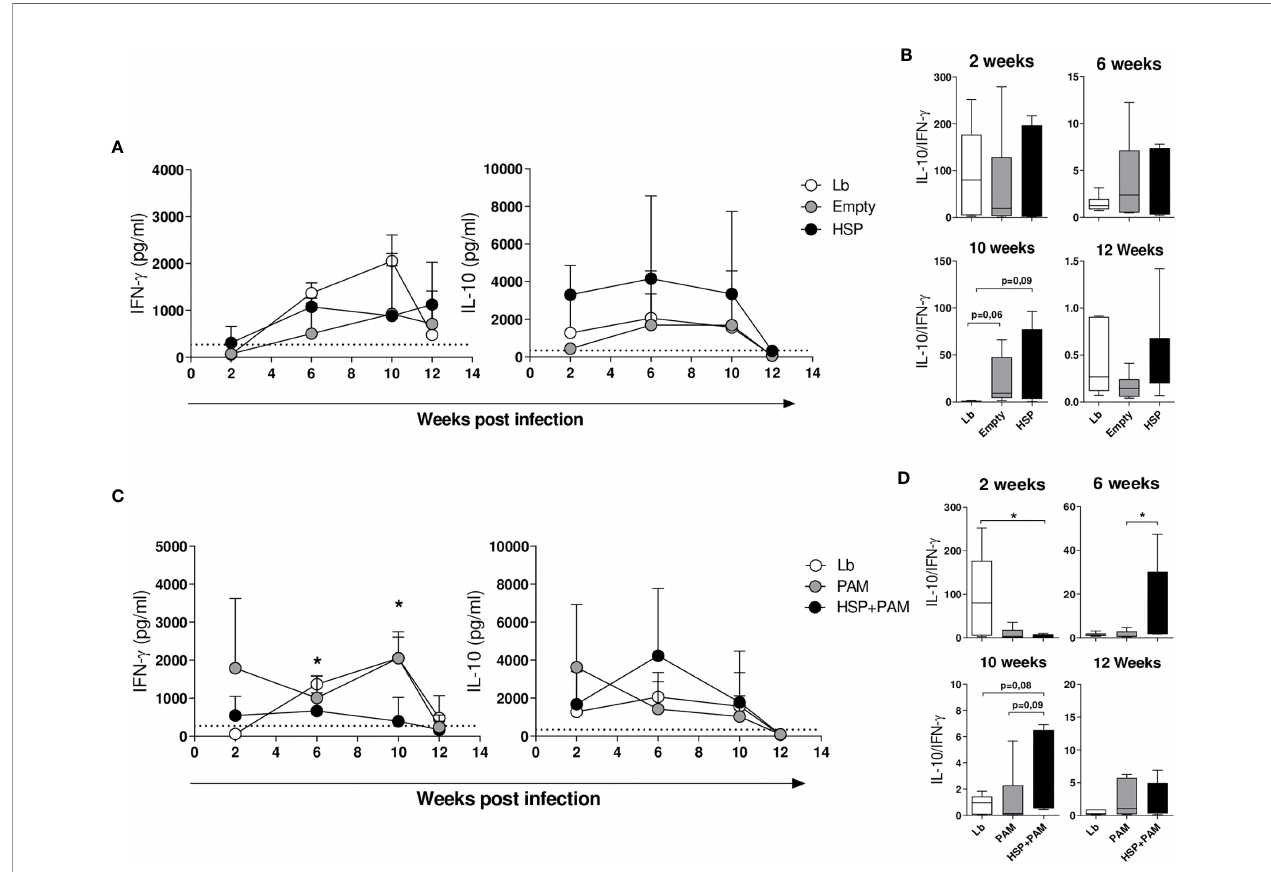
FIGURE 3 | Cytokine production in draining lymph node cells following re-stimulation with L. braziliensis. Mice were treated with water (Lb and PAM), GM17 Medium with empty vector-bearing L. lactis (Empty) or XM17 medium containing Hsp 65-producing L. lactis (HSP and HSP+PAM) for 4 consecutive days, then inoculated with L. braziliensis metacyclic promastigotes in the ear 10 days later. Two days prior to infection, the HSP+PAM and PAM groups received an intraperitoneal administration of PAM3CSK4. After euthanizing animals at 2, 6, 10 and 12 weeks post-infection, draining lymph node cells were collected, cultured and restimulated in vitro with live promastigotes of L. braziliensis (1 cell:5 parasites). After 72h, the cell culture supernatants were collected to measure cytokines by ELISA. (A) IL-10 and IFN- g production in Lb, Empty and HSP mouse groups. (B) IL-10:IFN- g ratio in HSP, Empty and Lb mouse groups. (C) IL-10 and IFN- g production in Lb, PAM and HSP+PAM mouse groups. (D) IL-10:IFN- g ratio in Lb, PAM and HSP+PAM mouse groups. Dashed lines represent cytokine production in the absence of stimulus. (A, C) cytokine production is represented the mean ± SD. (B, D) IL-10:IFN- g ratio is represented as medians and interquartile range. Data are representative of four independent experiments involving 10 animals per group. For nonparametric data, Kruskal-Wallis with Dunn ’ s post-test was used; (*) indicates P < 0.05 Lb and HSP+PAM at 6 and 10 weeks in (C) , PAM and HSP+PAM at 10 weeks in (C)